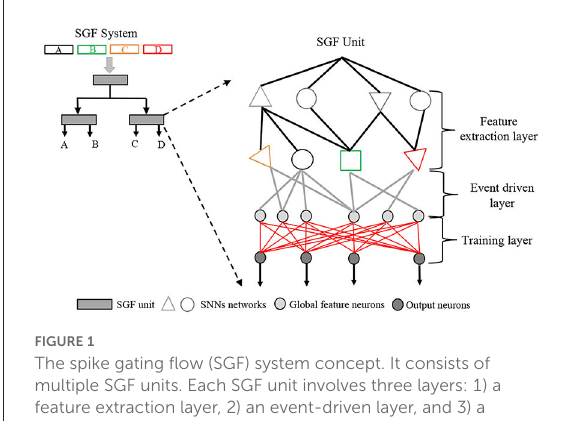
FIGURE1 The spike gating flow (SGF) system concept. It consists of multiple SGF units. Each SGF unit involves three layers: 1) a feature extraction layer, 2) an event-driven layer, and 3) a training layer. On the top left, there is an example of a four-event classification SGF system: A, B, C, and D are four event